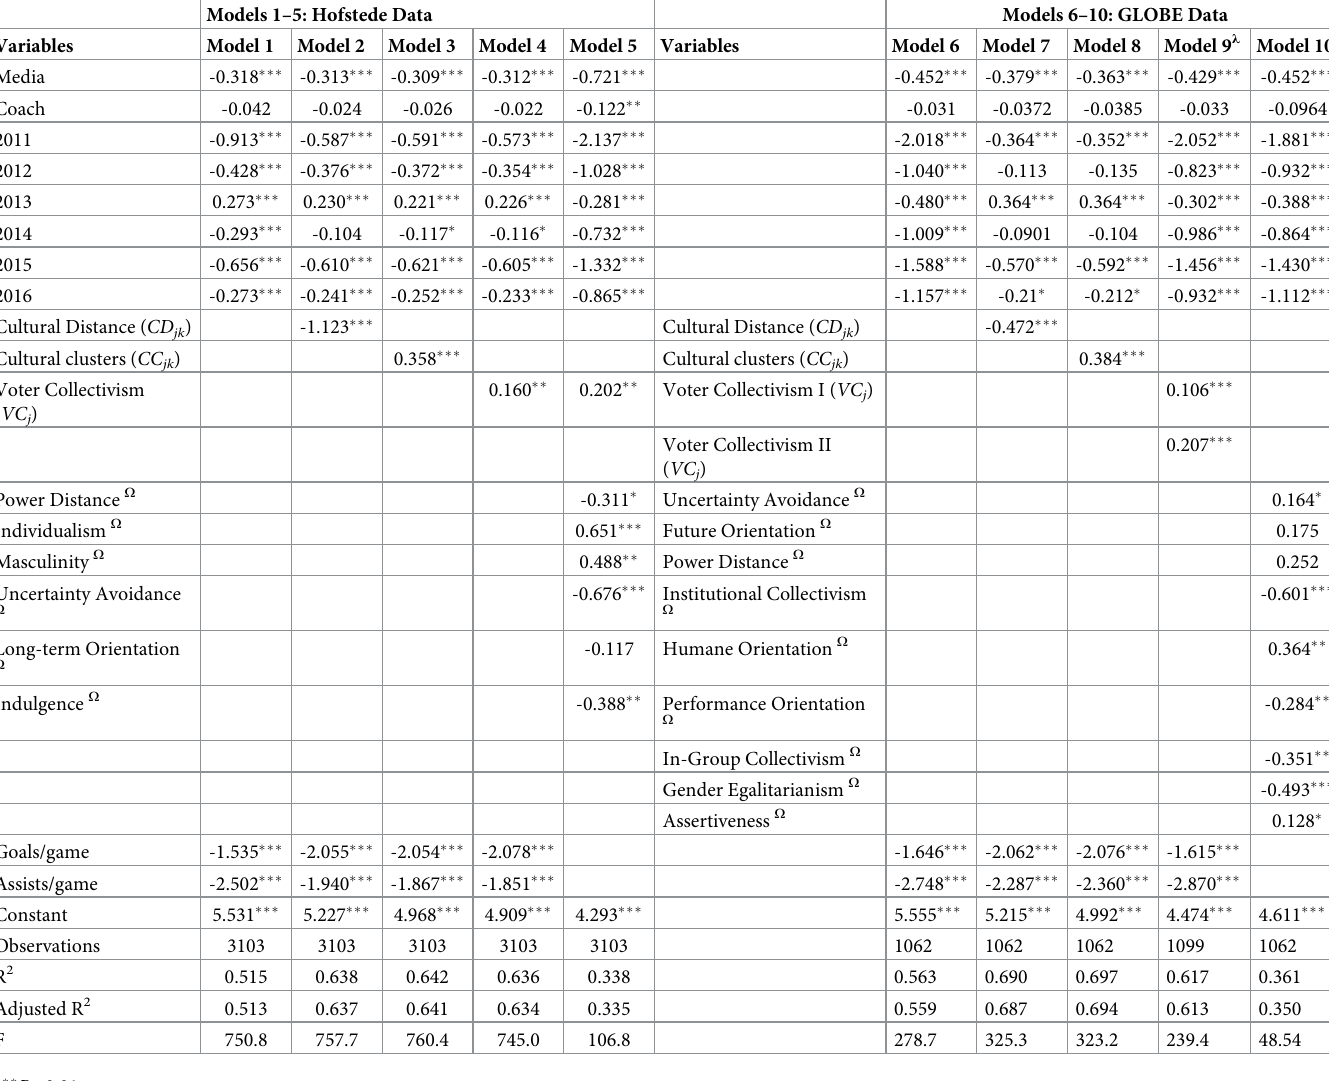
Table 4. Hypothesis 2 (Cultural): Regression models on voting bias for 5 points awarded using both Hofstede and GLOBE data sets. Models 1–5: Hofstede